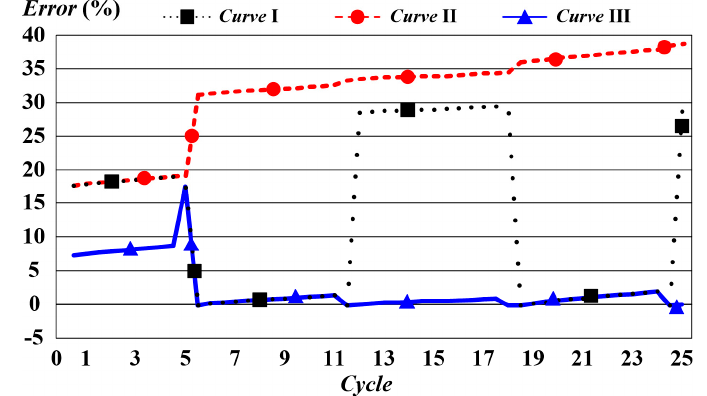
Figure 7. Estimation errors of different methods.